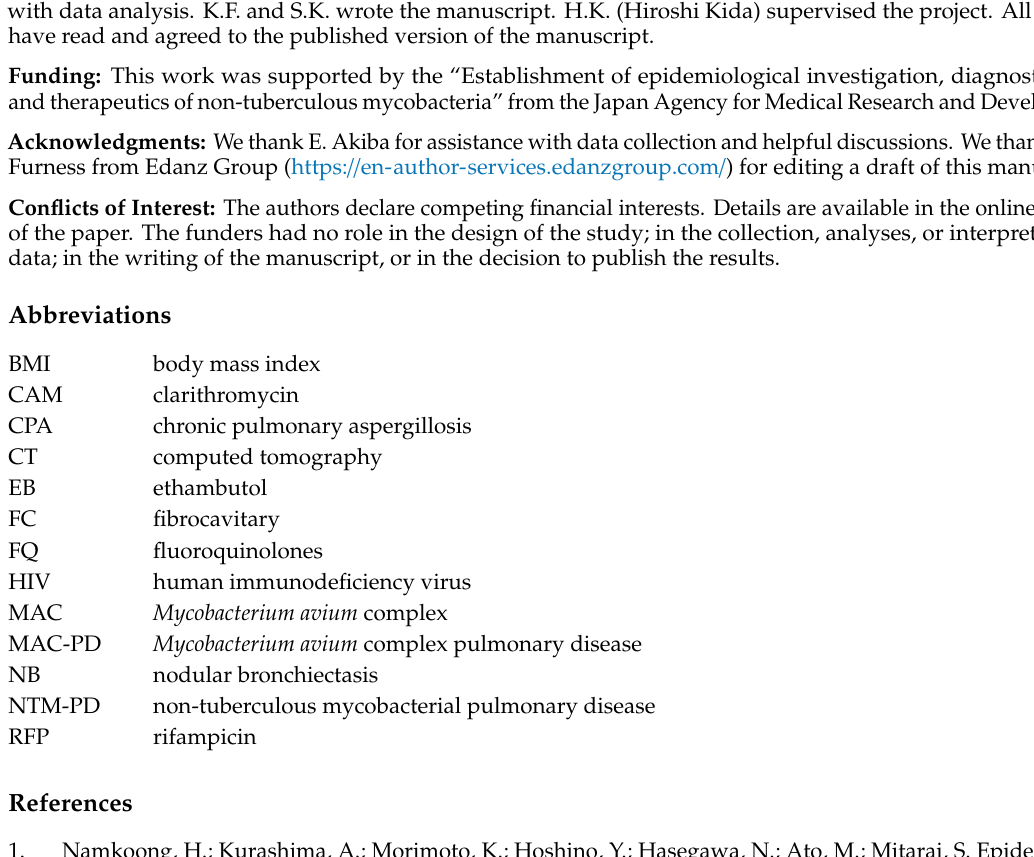
Figure S1: Study design, Figure S2: Analysis of MAC-PD associated